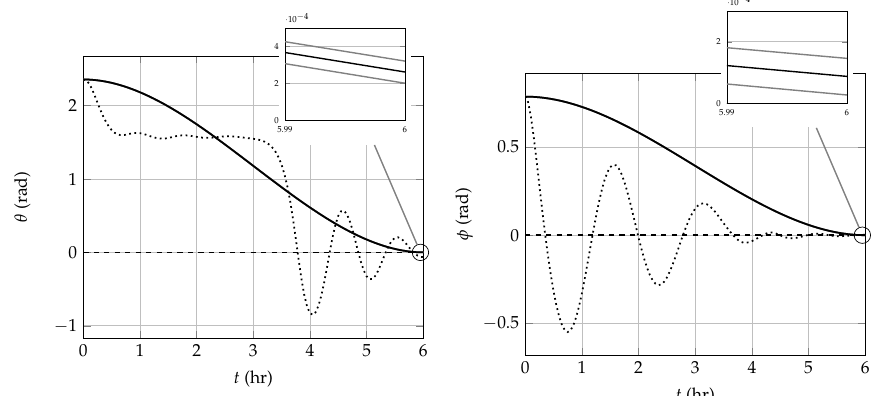
Figure 2. Angular displacement trajectories of the spacecraft. The black curves are the angular displacements of the actual nonlinear system, whereas the gray curves are the angular displacements of the auxiliary linear systems. The dashed line is the desired final position and the dotted line a solution using a non-convex solver.